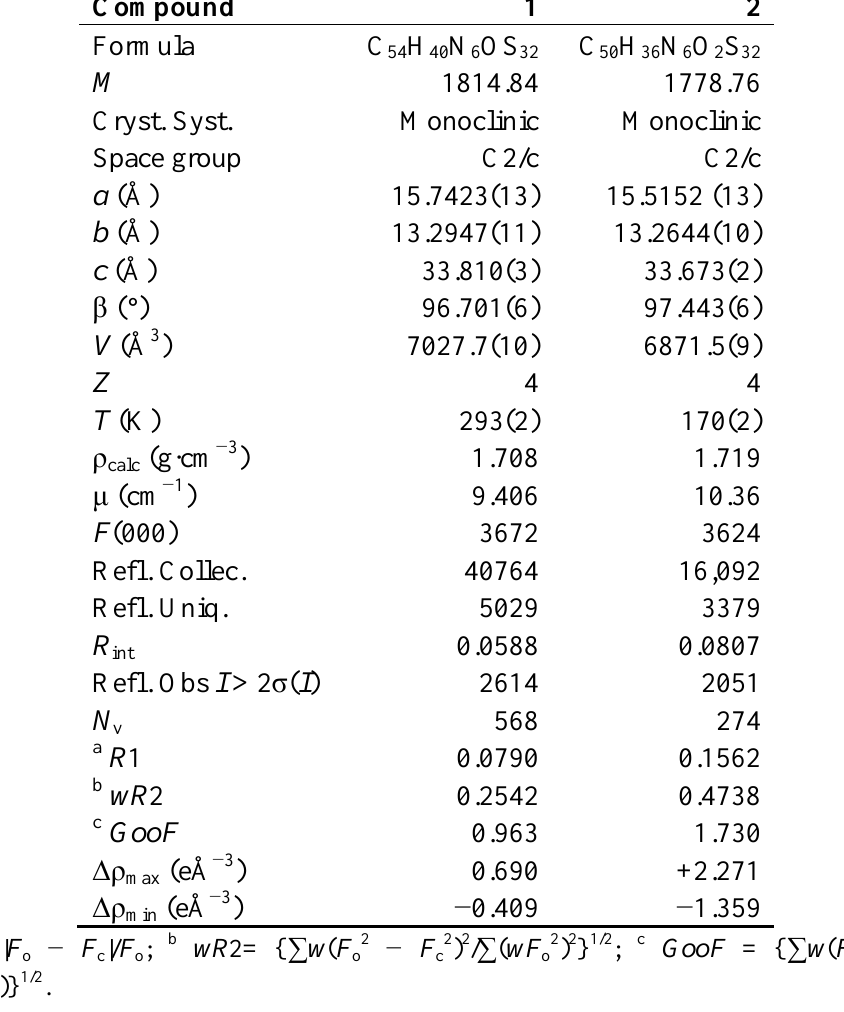
(tcpd)(THF) ( 1 ) and α'-ET 4